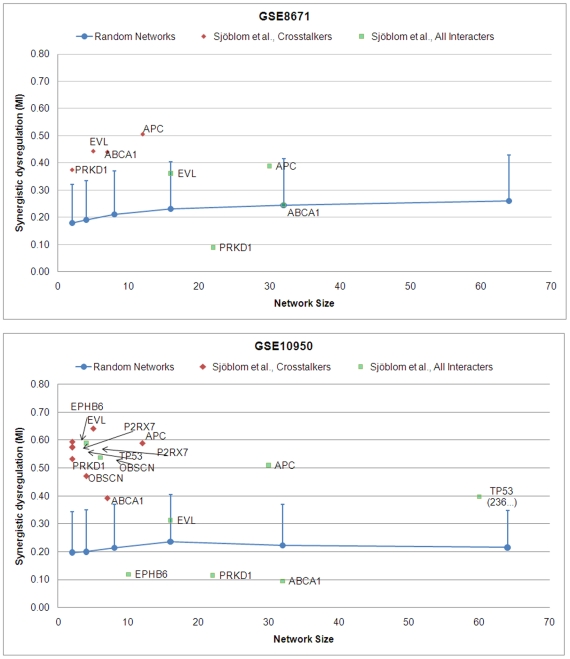
Synergistic dysregulation versus network size for candidate sub-networks associated with the CRC driver gene seeds obtained from Sjöblom et al.Please see Figure 3 for annotation.